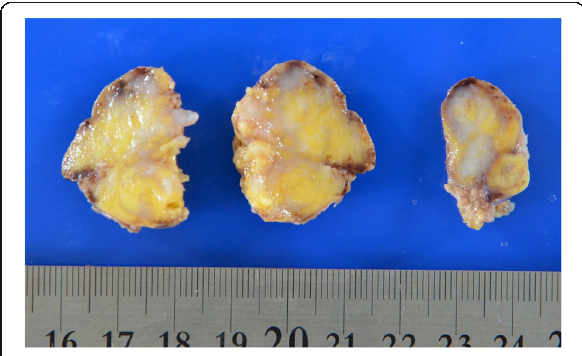
Fig. 2 Gross appearance of the resected specimen showed the cut surface of the tumor was whitish, yellowish, and